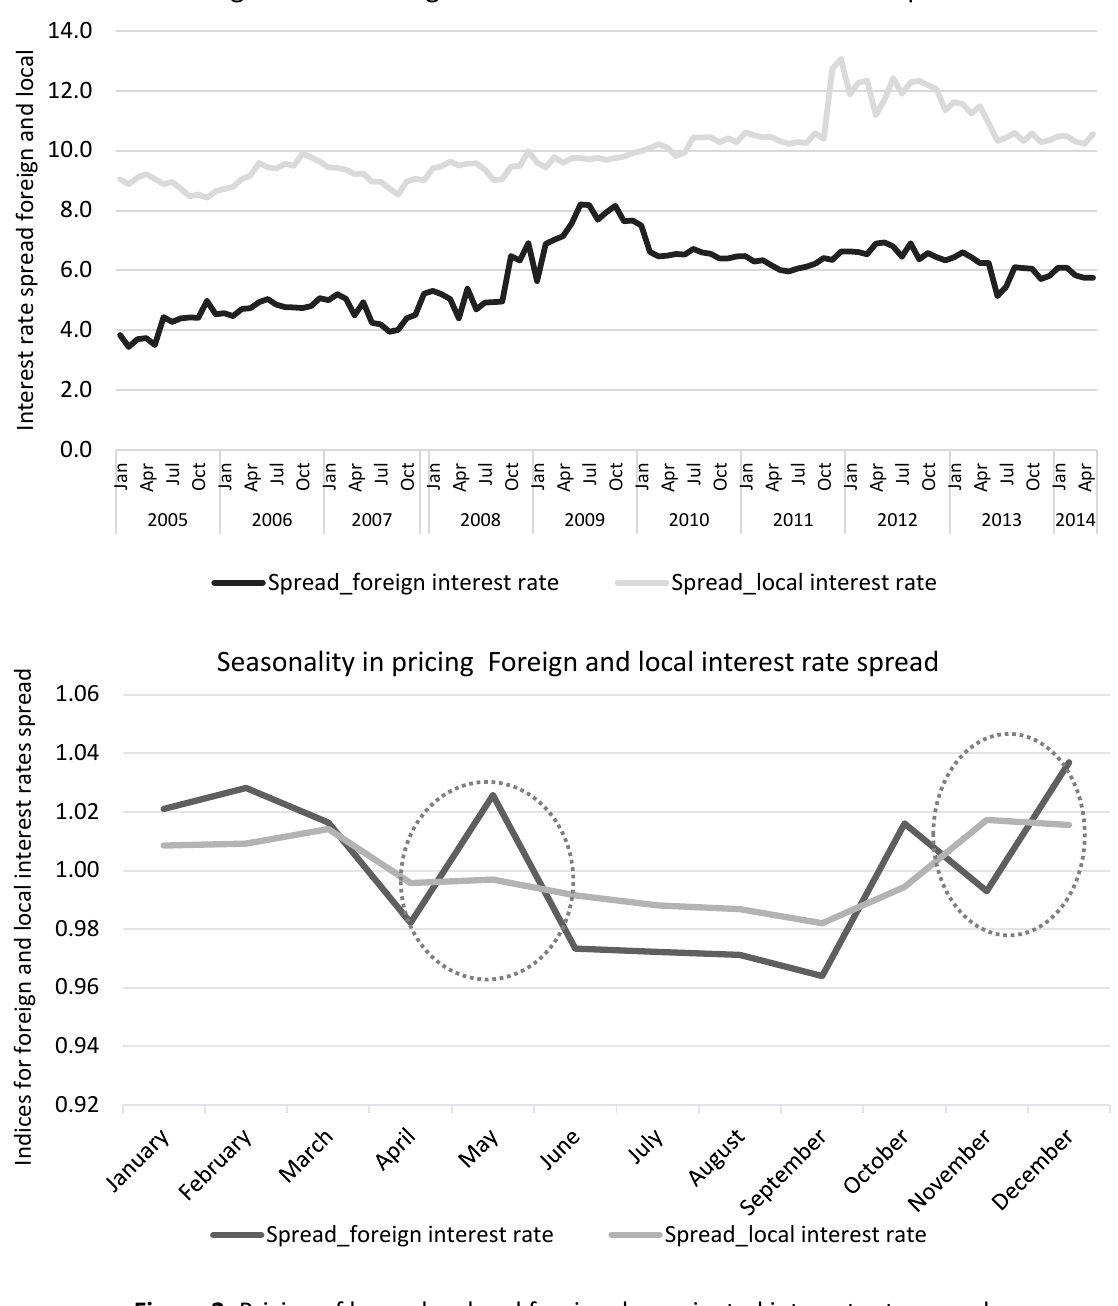
Figure 2. Pricing of loans: local and foreign denominated interest rate